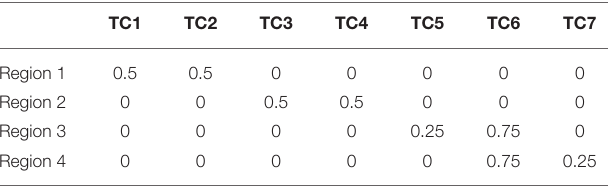
TABLE 1 | Proportions of the seven time courses in the four